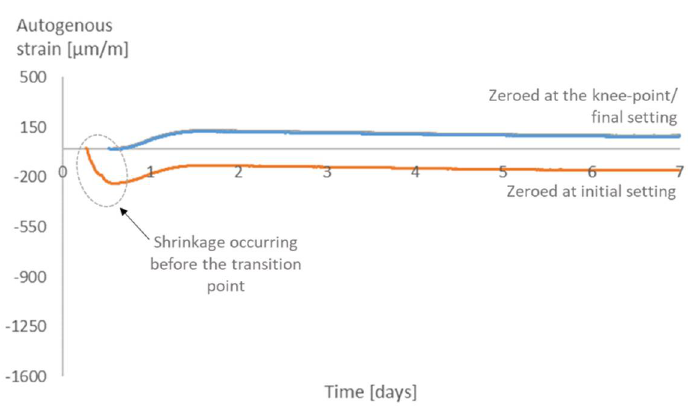
Figure 13. Autogenous strain for different time-zeros in SAP1.